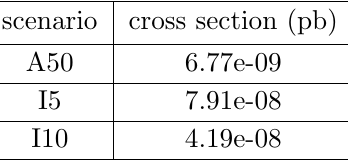
Table 5 . The background process, h decay into two charged scalars, cross section for m DM =54 GeV.